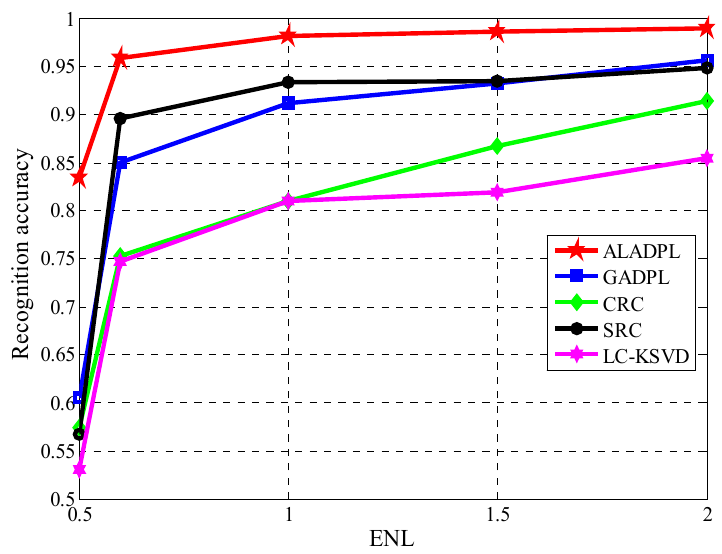
Figure 19. Performance of the algorithm with varying ENLs. Table 4. Performance of the algorithm with different SNRs.